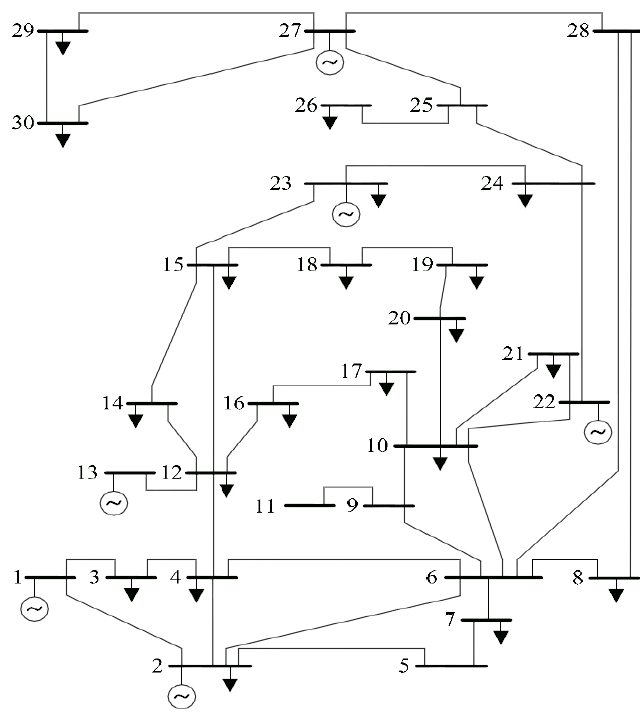
Figure 6. IEEE 30 bus system. Note: Generators are on buses—1, 2, 5, 8, 11, and 13.